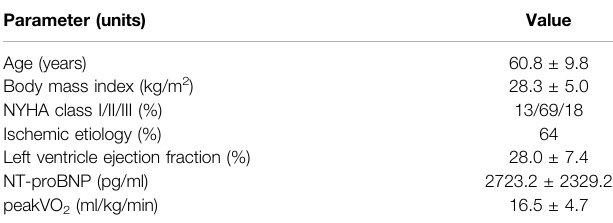
TABLE 1 | Baseline clinical characteristics of all studied